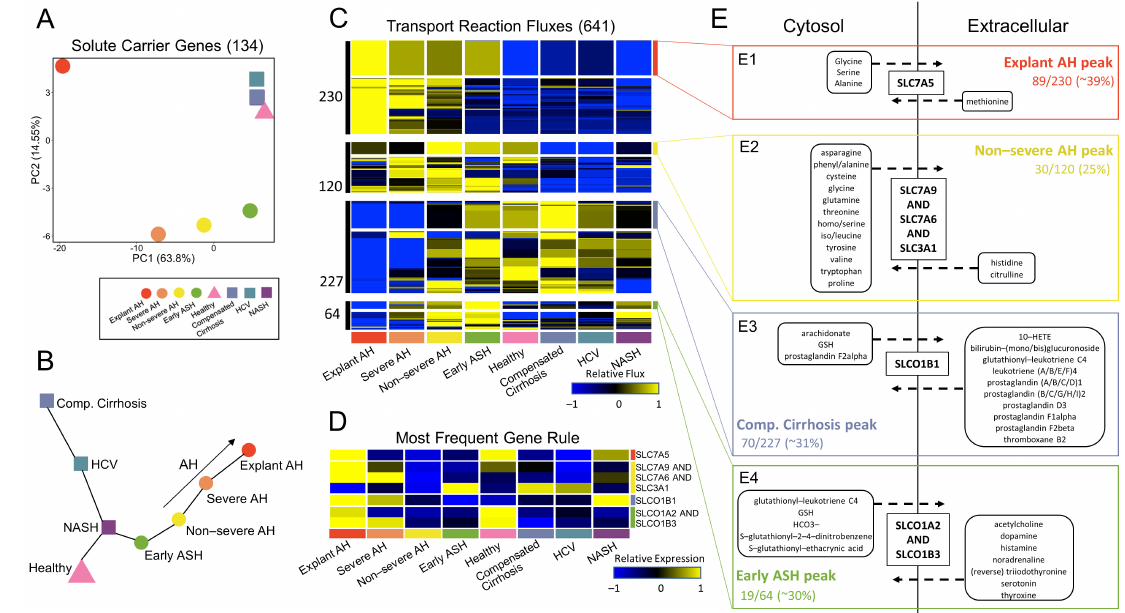
Figure 5. Regulatory and functional activity of solute transporters. ( A ) PCA plot for the 134 solute carrier (SLC) genes. ( B ) MST plot for the SLC genes. ( C ) Hierarchical clustering of fluxes from the transport reaction subsystem reveals four clusters. For each cluster, the gene rule associated with each reaction was identified. The reactions with the most frequent gene rule are annotated for each cluster. ( D ) The associated gene expression for each of the most frequent gene rules in ( C ) is shown. ( E ) A metabolic pathway map for each of the clusters with associated most frequent gene rule is shown. ( E1 ) shows sequentially increasing flux behavior with AH severity, peaking at explant AH, for reactions with gene rule SLC7A5. ( E2 ) shows increasing flux activity from healthy to non-severe AH, at which the fluxes peak, for reactions with gene rule SLC7A9 and SLC7A6 and SLC3A1. ( E3 ) shows fluxes peaking at compensated cirrhosis for reactions with gene rule SLCO1B1. ( E4 ) shows sequentially increasing flux behavior with decreasing AH severity, peaking at early ASH, for reactions with gene rule SLCO1A2 and